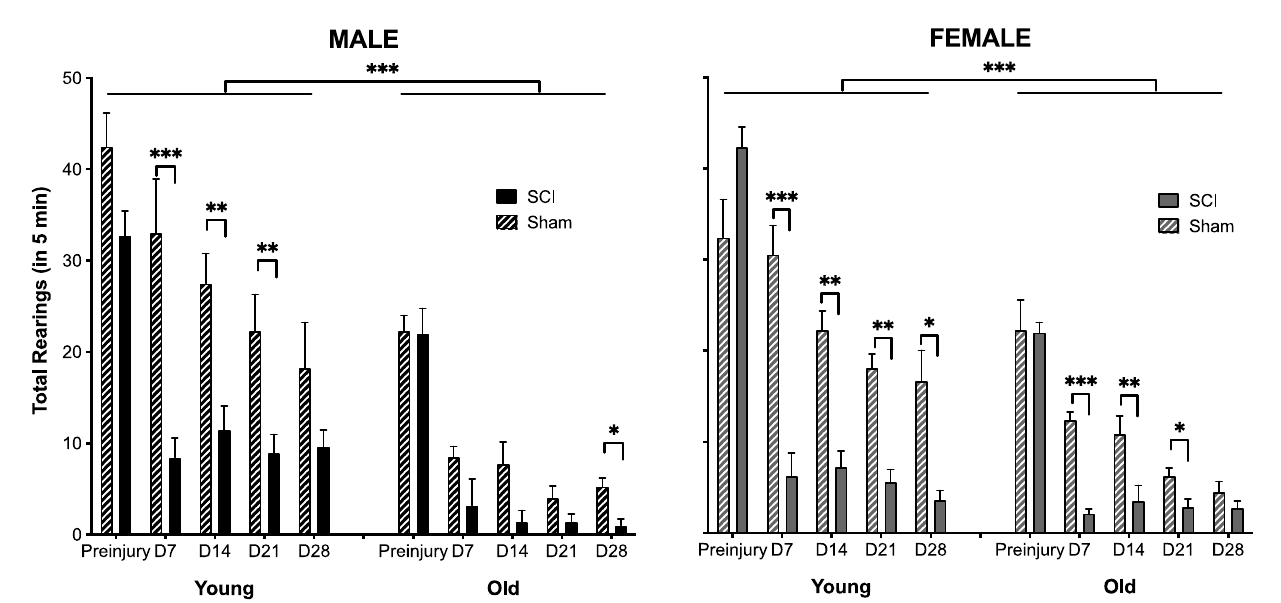
Figure 3. Age and SCI affected rearing activity. The young mice reared more than the old mice and SCI reduced rearing activity relative to sham controls, irrespective of the demographic observed. There was no effect of sex on rearing behavior. Days (D) post injury are denoted on the x-axis, with the mean (±SEM) number of rears in 5 min shown on the y axis. n= 4 sham and 5 SCI old males; 4 sham and 11 SCI young males; 8 sham and 7 SCI old females; 7 sham and 8 SCI young females. *** p < 0.0001, ** p < 0.001, * p < 0.01.